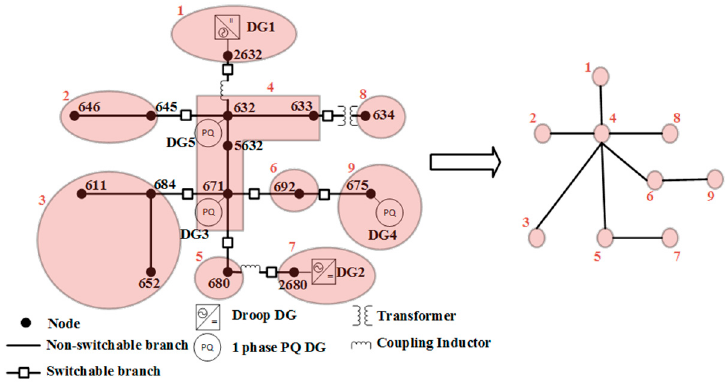
Figure 9. Illustration of bus block reduction using Modified IEEE 13 node test feeder.